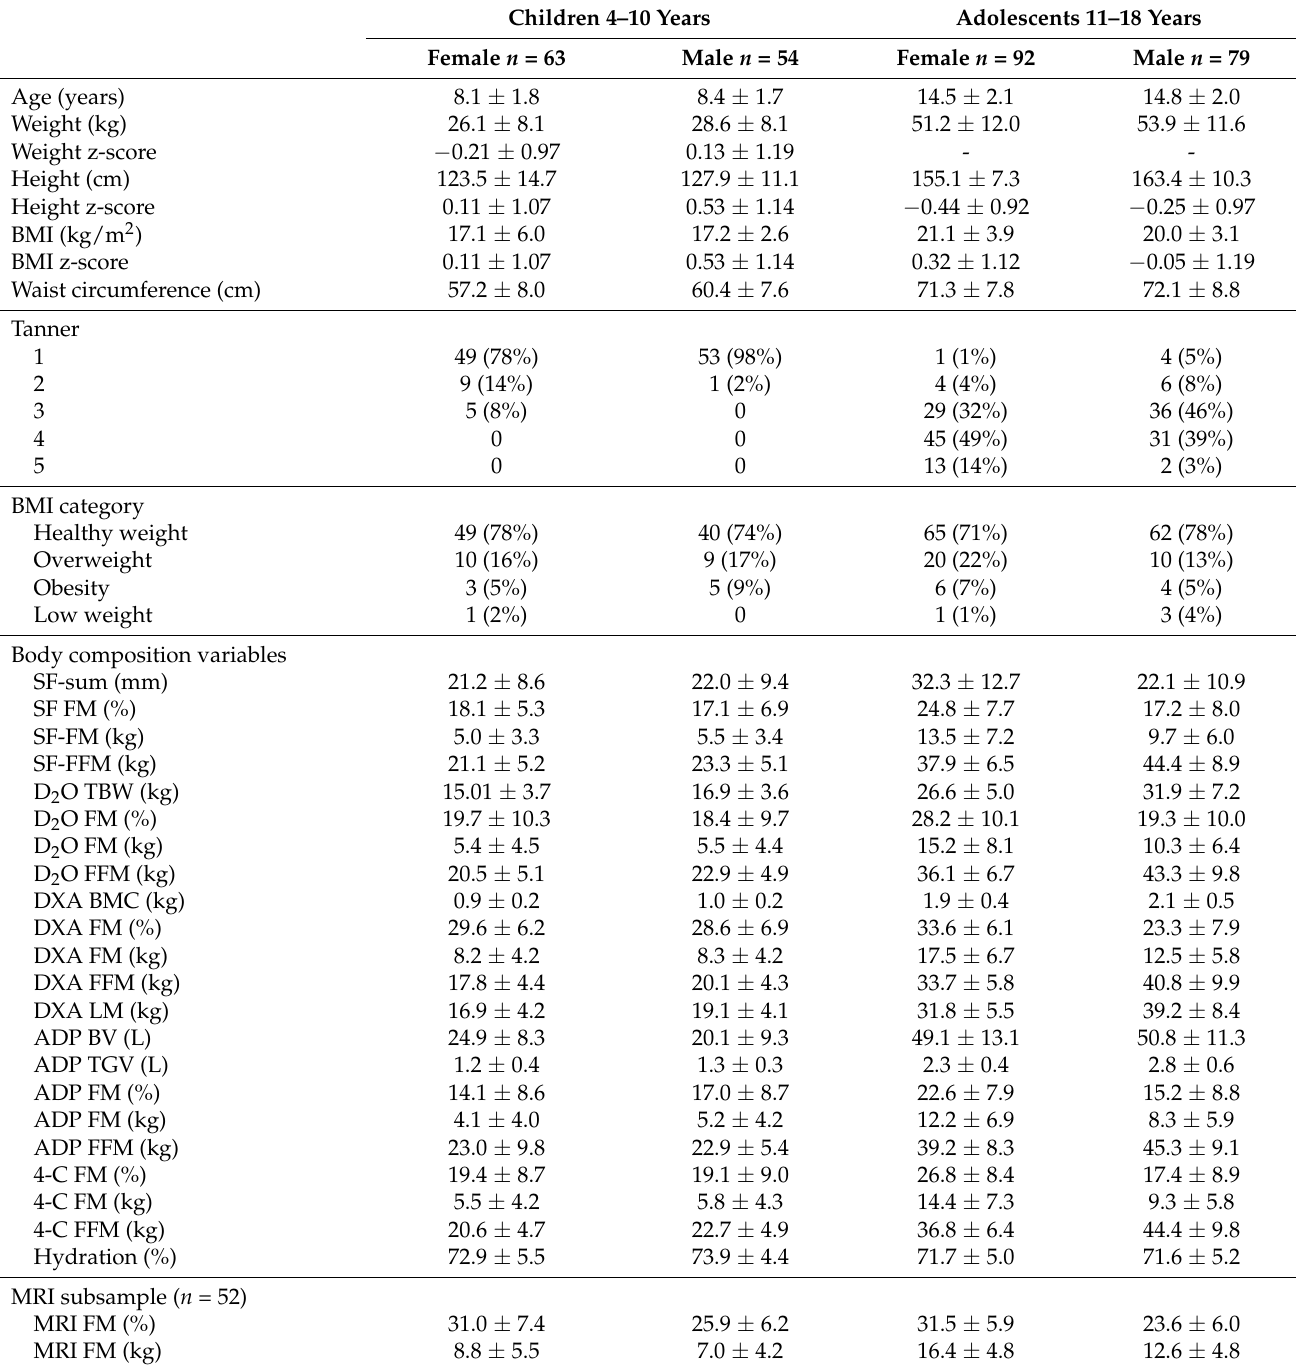
Table 1. Demographic and data on measurements by age and sex groups ( n =